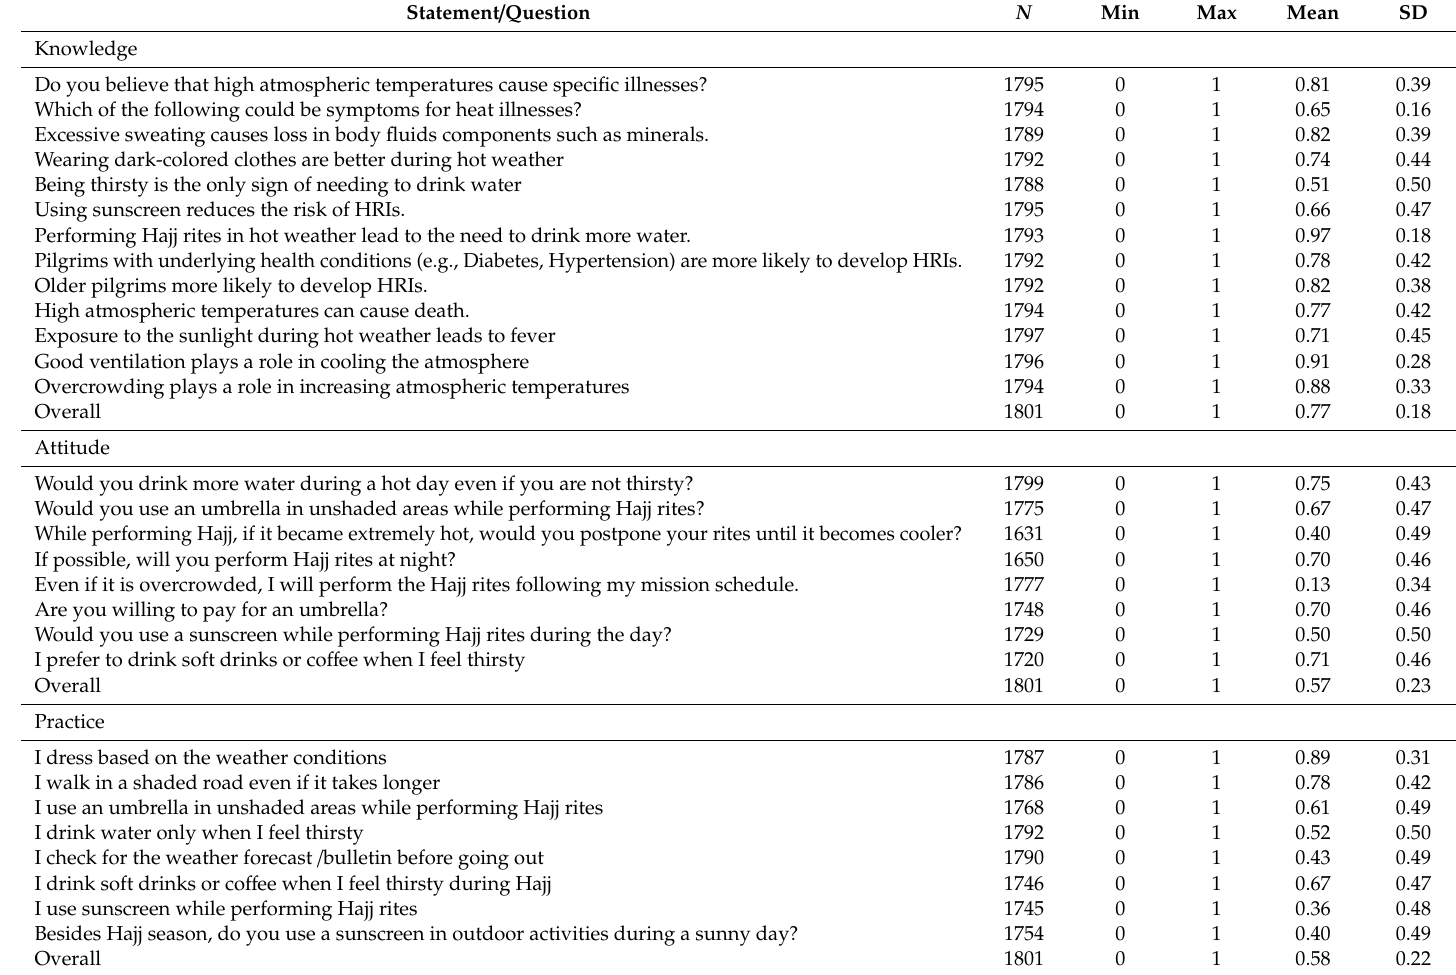
Table 2. Mean hear-related illness knowledge, attitude and practice